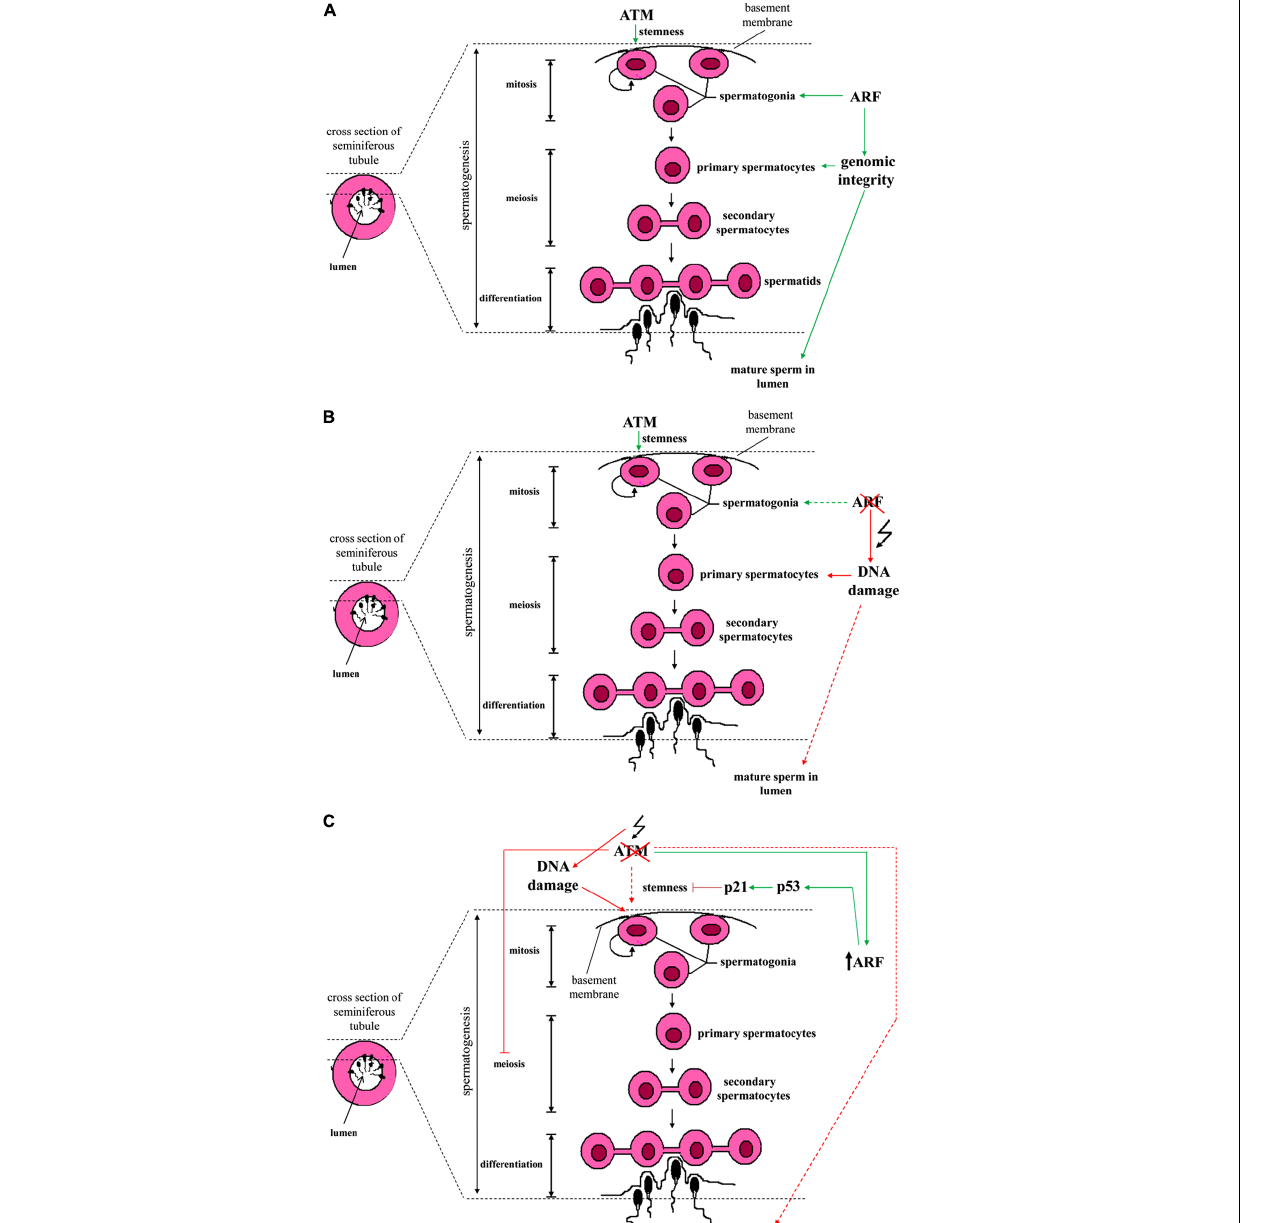
FIGURE 1 | Schematic presentation of the spermatogenesis stages across the wall of a seminiferous tubule and the interrelations with ATM and ARF. (A) Spermatogonia are found in close proximity to the basement membrane of a seminiferous tubule. A subpopulation of spermatogonia exhibits stem cell ability and self-renews via mitotic divisions. ATM kinase is essential for their stemness (symbolized by a semicircular shape). Some of the spermatogonia eventually differentiate into primary spermatocytes. The latter, undergo meiosis to give rise to secondary spermatocytes which in turn, form spermatids (connected via cytoplasmic bridges). Spermatids engage a series of cytodifferentiative programs and sperm is finally formed. ARF expression in spermatogonia is required in order to prevent the occurrence of DNA damage in meiotic primary spermatocytes (at the stage of pachytene) through participating in a feed-forward program. (B) In the absence of ARF, genomic integrity in